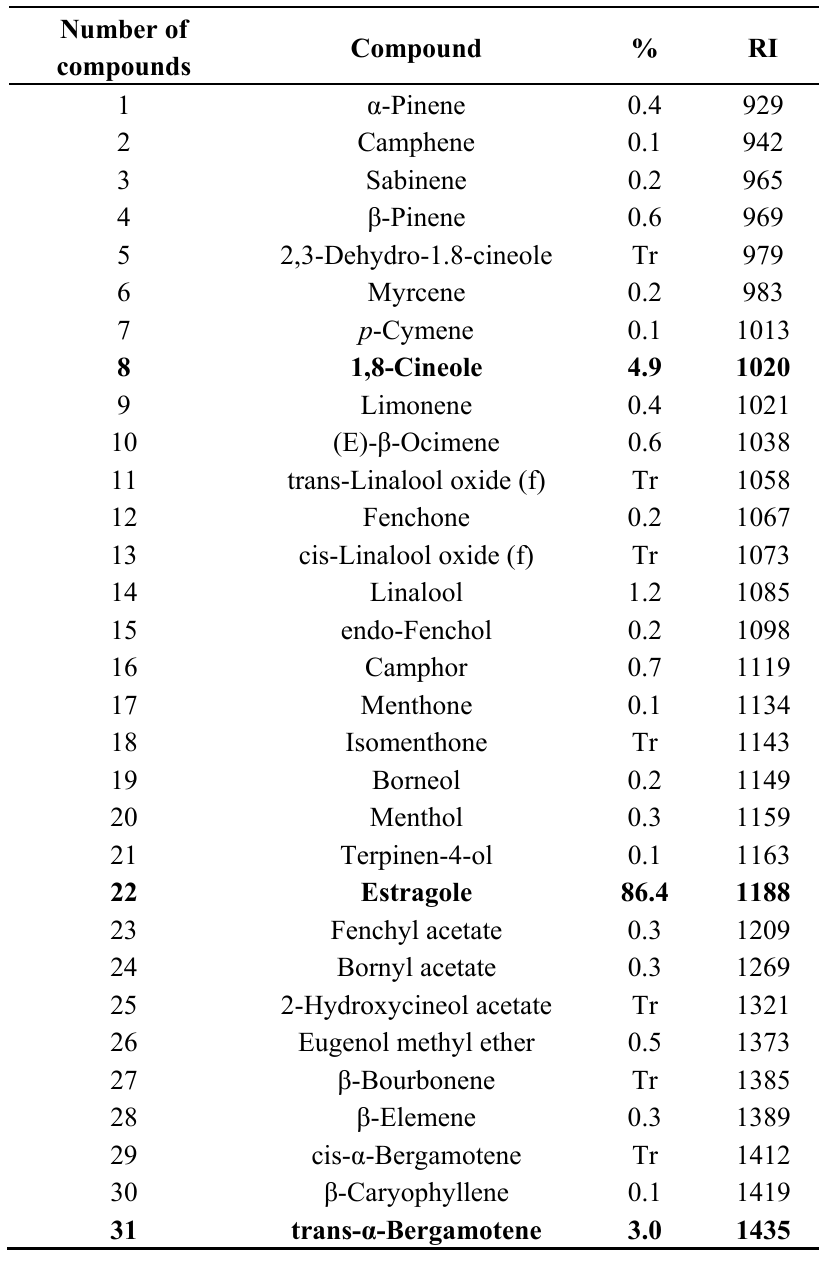
Table 1. Constituents of basil